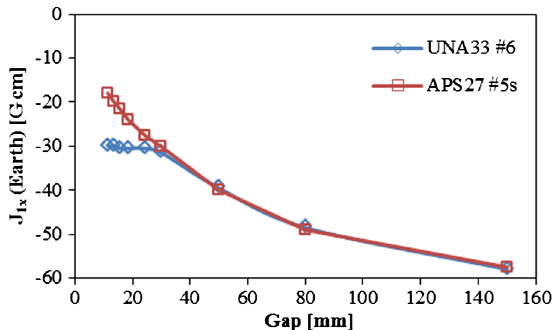
FIG. 1. Effects of the propagation of the transverse horizontal Earth ’ s field component in the UNA33 #6 and in the APS27 #5s. First field integral gap dependence is